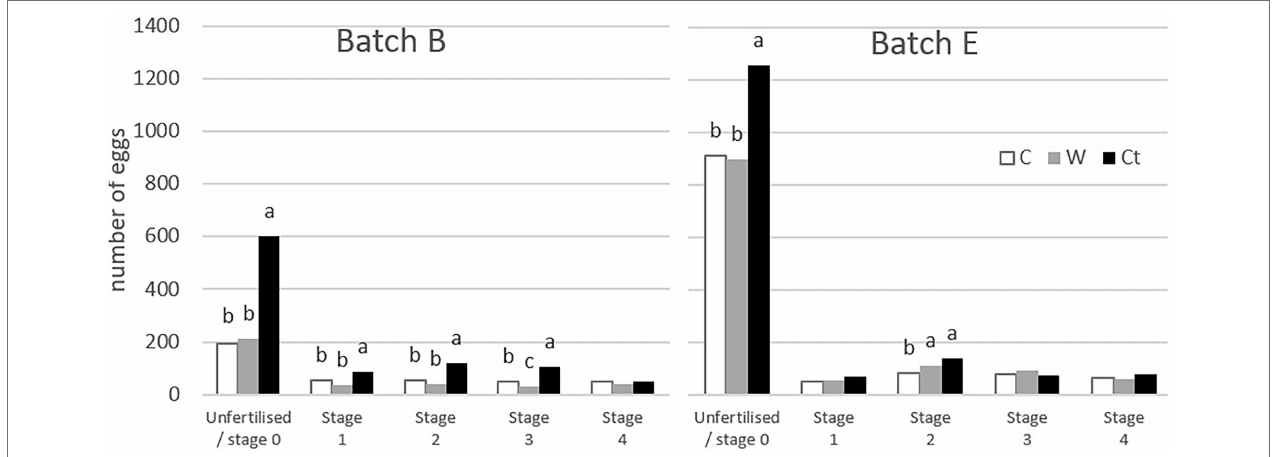
FIGURE 3 | Mortality stage of embryos from unhatched eggs (at ED21) and semi-transparent eggs (at ED18; B: eggs from breeder flock at the beginning of the laying period and E: end of the laying period). Ct: control group; C: cool storage; and W: warm storage. a, b and c: values not associated with common letters within stages are statistically different at threshold p < 0.05 [comparing numbers relative to the number of incubated eggs